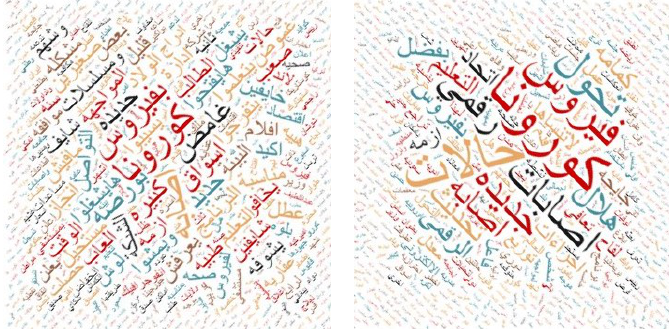
Figure 2: Instances of word cloud in twitter data